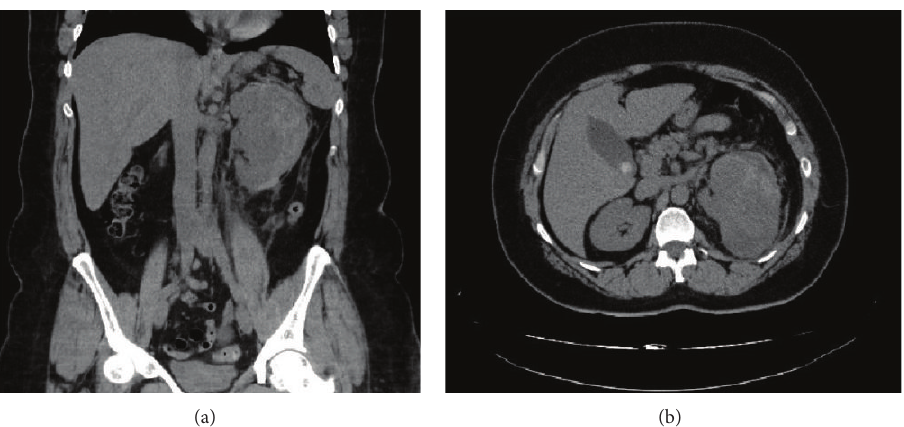
Figure 1: (a) The coronal reconstructed CT image shows a large solid heterogeneous mass without calcifications in the left kidney and also a perirenal hematoma. (b) The axial CT image of the upper abdomen reveals a large solid heterogeneous mass measuring 7 × 6.7 in the left kidney and also a perirenal hematoma.